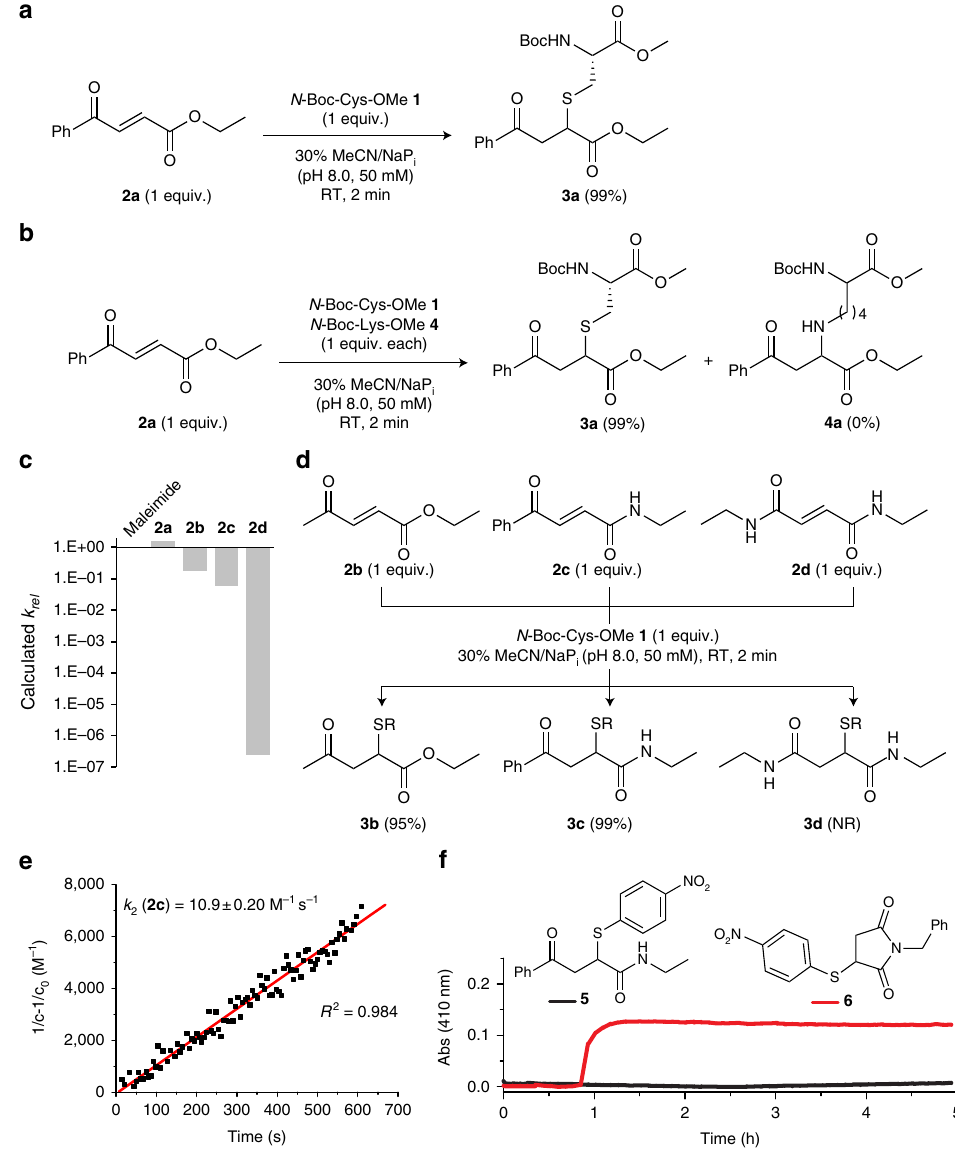
Figure 1 | Identification of a suitable carbonylacrylic derivative for reaction with Cys. ( a ) Reaction of 2a with N -Boc-Cys-OMe 1 provides the thioether product 3a in 99% yield after 2min. ( b ) Reaction of 2a in an equimolar mixture of 1 and N -Boc-Lys-OMe 4 shows complete Cys chemoselectivity. ( c ) Relative reaction rates at 25 (cid:2) C ( k rel ) calculated for the conjugate addition of methyl thiolate to maleimide and 3-carbonylacrylic acid derivatives 2a – d . ( d ) Reaction of derivatives 2b – d with 1 . ( e ) Experimental determination of the second-order rate constant for the addition of compound 2c to 1 . See the Supplementary Methods for additional details and kinetics data for compound 2a . ( f ) Kinetic assay for the stability of chromogenic thiol adducts 5 and 6 at physiological pH. The absorbance of 5 at 410nm is constant over time, indicating no release of 4-nitrophenolate. In contrast, for 6 , a steady increase in absorbance over time was observed. It is important to note that although both compounds absorb at 410nm, we have set the initial absorbance to zero for clarity. The original data for 5 ( A 0h ¼ 0.45nm, A 5h ¼ 0.45nm) and for 6 ( A 0h ¼ 0.23nm, A 5h ¼ 0.35nm) is presented in the Supplementary Fig. 7. NR, no reaction; RT, room